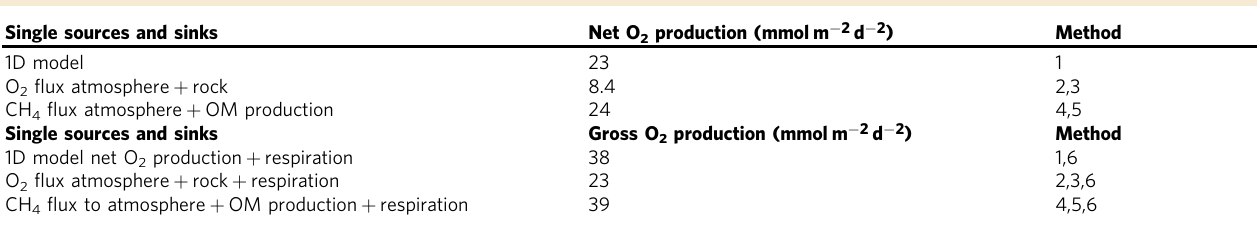
Table 1 Gross and net oxygen production Single sources and